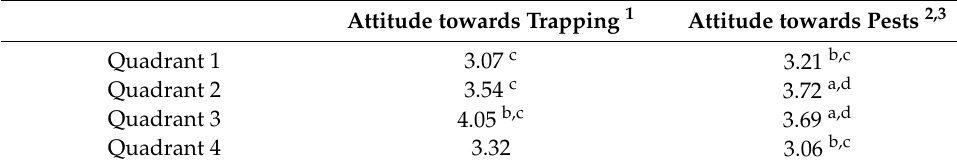
Table 7. I 3 classification and attitudes towards trapping possums.